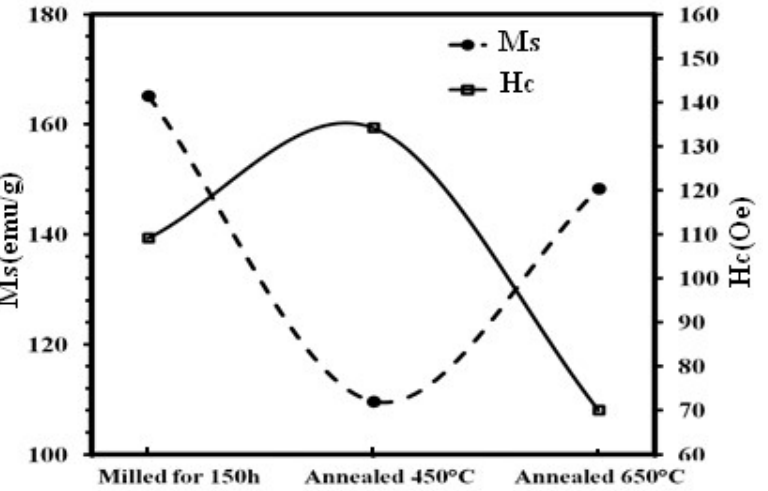
Figure 11. Variation of saturation magnetization (M s ) and coercivity (H c ) of Fe 70 Ni 12 B 16 Si 2 powders after milling for 150 h and heat treatment. after milling for 150 h and heat